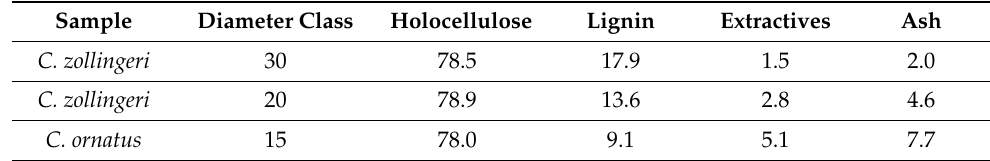
Table 4. Chemical composition of rattan samples in different diameter classes (wt%).